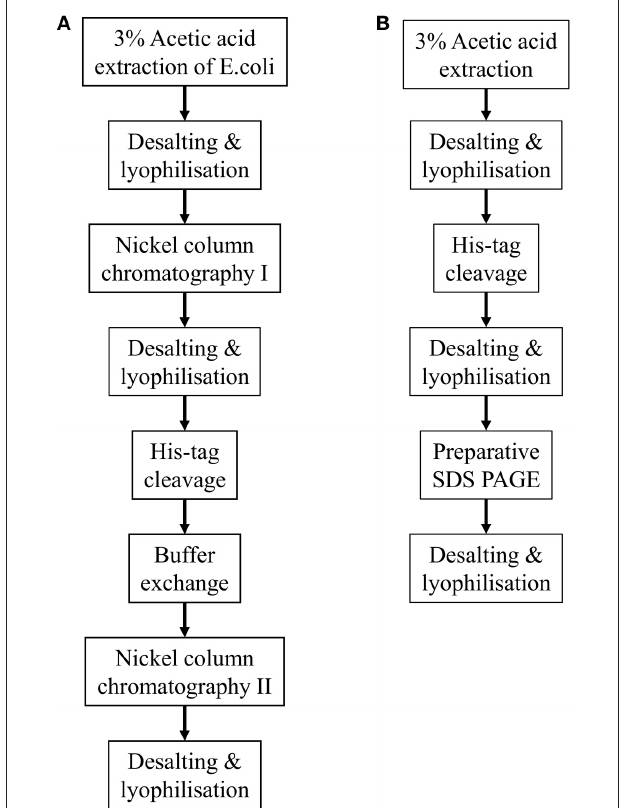
FIGURE 1 | Flow diagrams summarizing the two methodologies described for purifying His-tagged recombinant amelogenin. (A) Purification of recombinant His-tagged amelogenin using conventional His-tag column purification. (B) Alternative methodology described here using preparative SDS PAGE in place of His-tag column chromatography to purify recombinant His-tagged amelogenin.